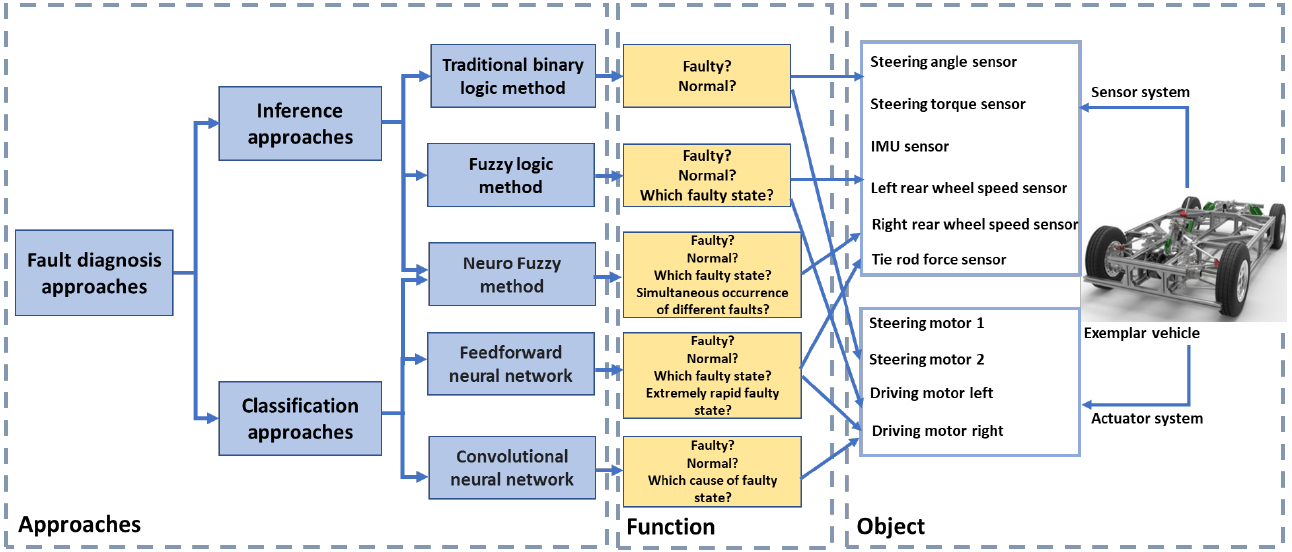
Figure 1. Overview of the approaches and their applications in this